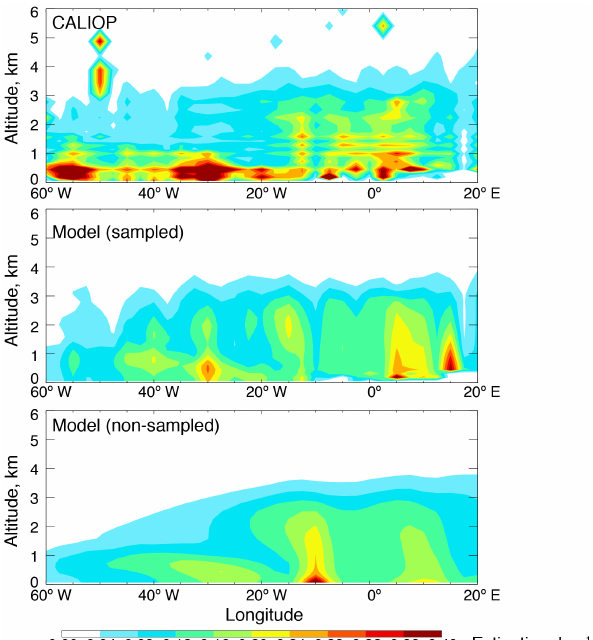
Figure 7. Curtain plots of extinction from CALIOP and model (sampled and non-sampled) averaged over 5–10 ◦ N and January– April